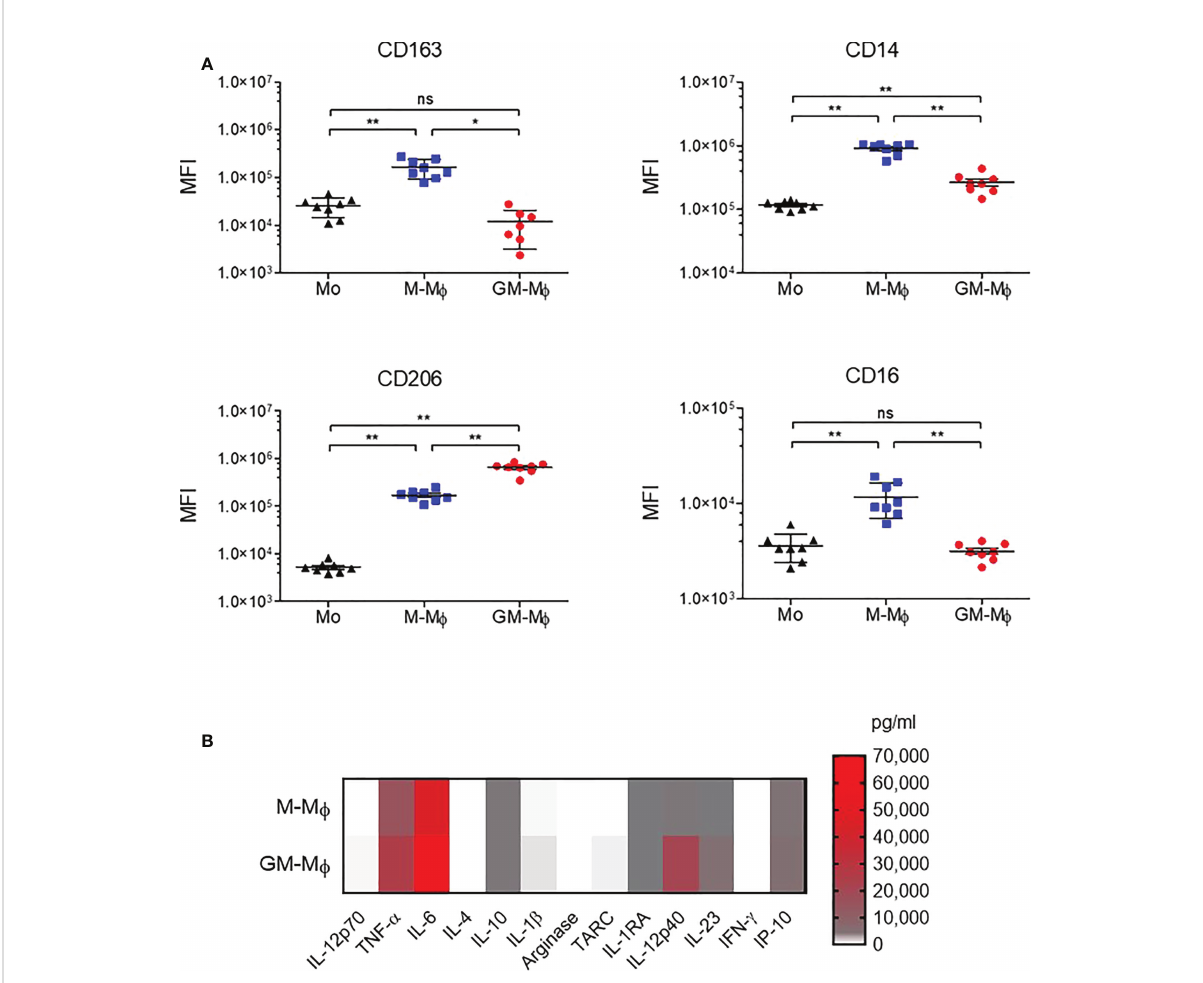
FIGURE 1 CD163, CD14, CD206 and CD16 analysis by fl ow cytometry during macrophage differentiation in GM-CSF or M-CSF. Human monocytes were cultured with 60 ng/ml M-CSF or GM-CSF for 6 days. (A) CD163, CD14, CD206 and CD16 expression was assessed by fl ow cytometry on day 0 in monocytes (MO) and day 6 in M-M f and GM-M f . Data are mean fl uorescence intensity (MFI) from eight independent experiments (mean ± SD, N=8). (B) Results of fl ow cytometry of cytokine secretion in M-M f and GM-M f after lipopolysaccharide stimulation represented as a heatmap (mean ± SD, N=9). Mo, monocytes; M-M f , M-CSF – induced macrophages; GM-M f , GM-CSF – induced macrophages. ns = not signi fi cant, *p ≤ 0.05 and **p ≤